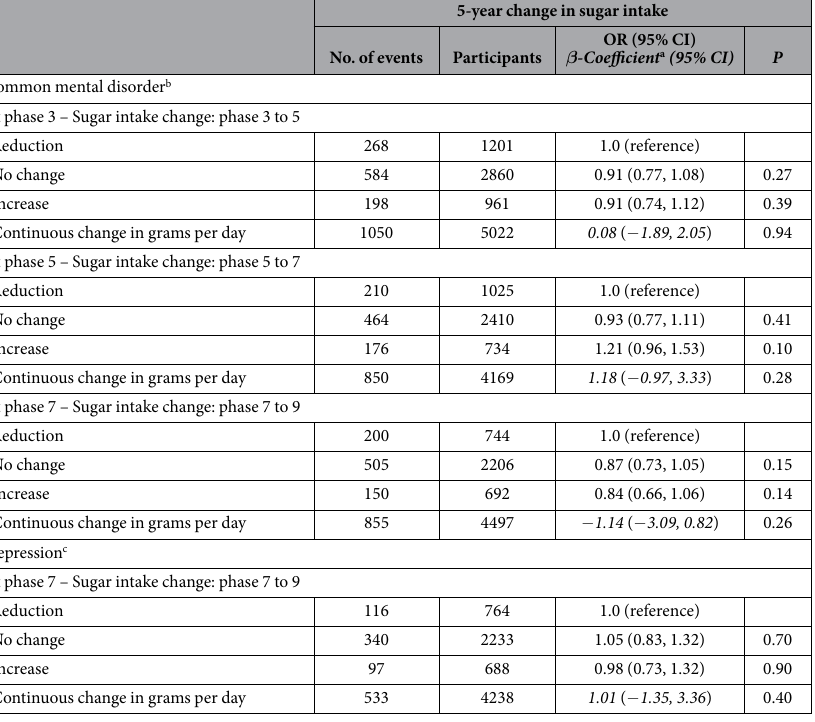
Table 5. Association of common mental disorder and depression with subsequent 5-year change in sugar intake from sweet food/beverages. Abbreviations: No. = number, CI = confidence interval. a Change in sugar intake in cases compared with non-cases, adjusted for age, sex and ethnicity. b Common mental disorder measured using the 30-item General Health Questionnaire. c Depression measured using 20-item the Centre of Epidemiologic Studies Depression